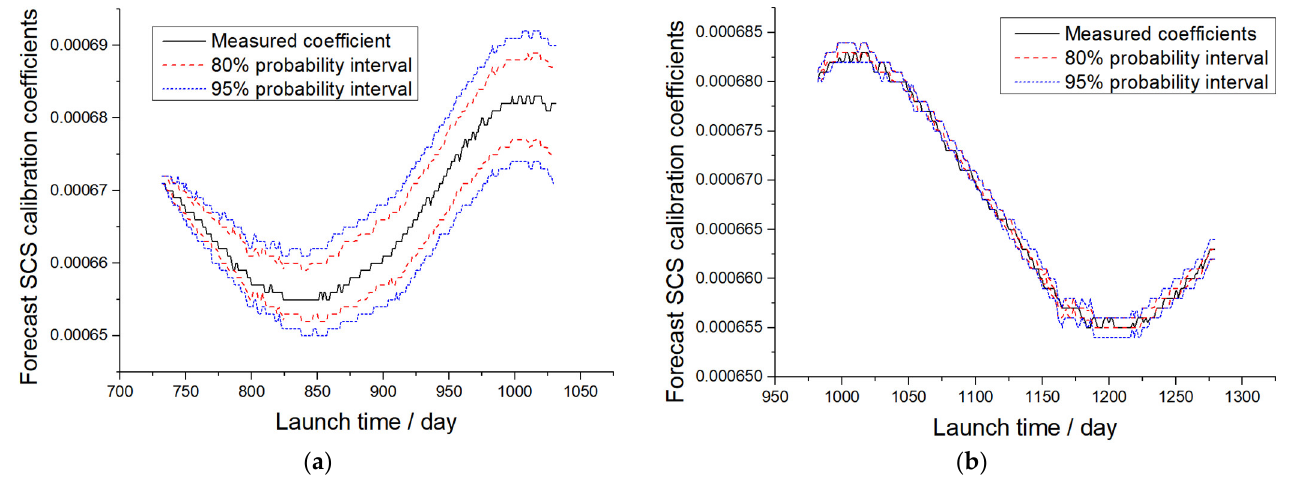
Figure 10. Probability intervals of 80% and 95% for forecast SCS calibration coefficients. ( a ) Shows the forecast result using the entire calibration coefficients and ( b ) shows the forecast result using the calibration coefficients data without the first 250 days.